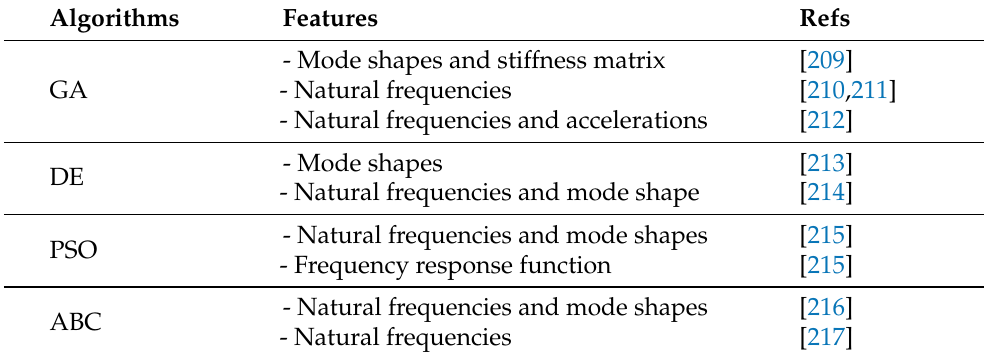
Table 16. Different types of features employed in some recent optimisation-based methods for damage detection of composite